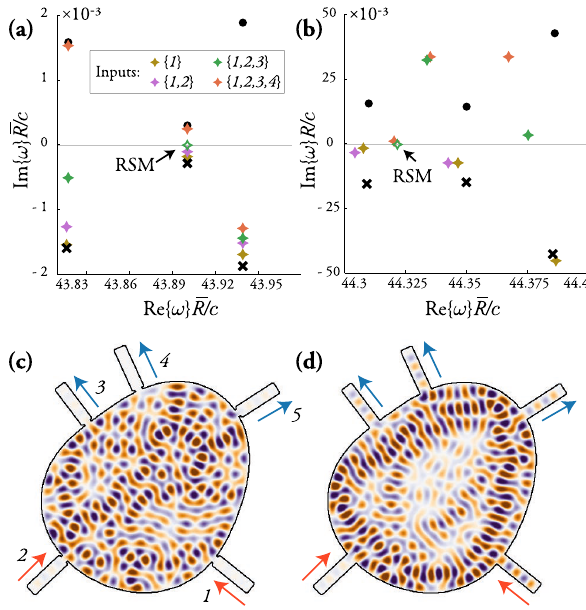
Figure5: Asymmetriclosslesswaveguidejunction/resonator(mean radius ¯ R ) coupled to fi ve single-mode waveguides, with constric- tions at the ports to the junction. (a) Numerically calculated R-zero spectrum for a weakly coupled, high- Q junction with well-isolated resonances. Black x and dot are purely outgoing (resonance) and incoming (S-matrix zero) frequencies, which are complex conju- gates. Colored stars are R-zeros for various choices of input chan- nels; the legend indicates which channels are inputs, with the channel labels given in (c). The R-zeros cluster vertically above the resonance frequency and below the S-matrix zero frequency, as predicted by single-resonance temporal coupled-mode theory (TCMT) approximation in Eq. (9) below. The common width of the constrictions for waveguides {4, 5, 6} is slightly tuned to make a 2-in/3-out R-zero real, creating a re fl ectionless scattering mode (RSM). (b) R-zero spectrum for the same junction but with the con- strictions opened, which lowers the Q of the resonances (note change in vertical scale). The linewidths of the resonances are now comparable to their spacing. Due to multiresonance effects, the R-zeros are spread out along the real and complex frequency axis and are no longer associated with a single resonance. Nonetheless, by slightly tuning the constriction width as before, a 2-in/3-out R-zero is again made real (RSM), as in the high- Q case. (c, d) The mode pro fi les of the RSMs for the high- Q (c) and low- Q (d)